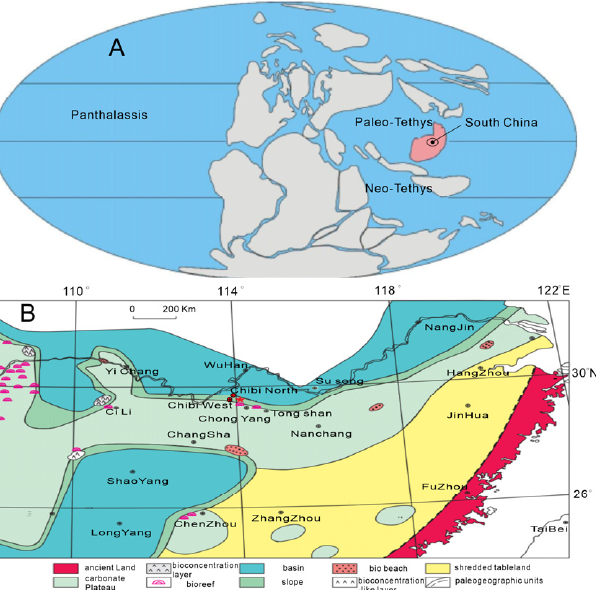
Figure 1. ( A ) Global paleogeography at the Permian-Triassic boundary, showing the location of South China (modified from [23]) ( B ) Paleogeographic context of the Late Permian Changhsingian period in South China, with the location of Chibi (modified from [24]).